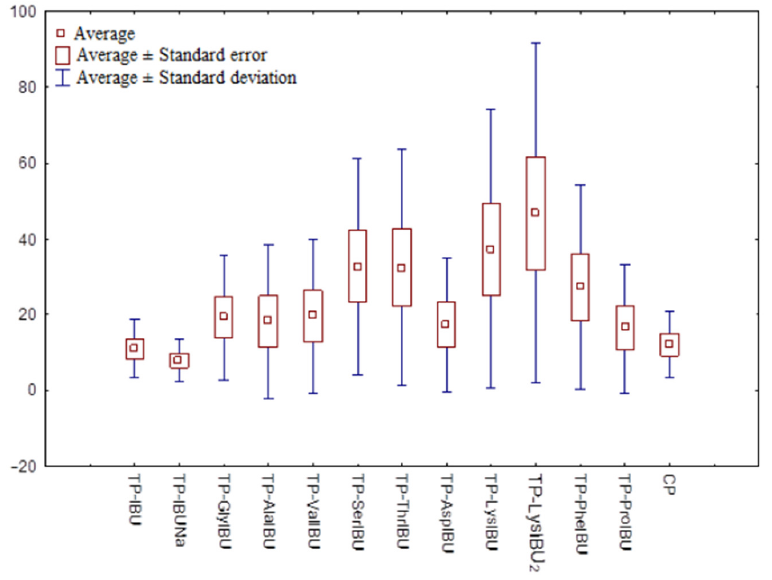
Figure 7. The box plot of cumulative mass for IBU and its derivatives after 24 h permeation. after 24 h of penetration. All the compounds used accumulated in the skin. The lowest accumulation for derivative IBU values was obtained for TP-AlaIBU (30.602 ± 2.847 µg IBU/g skin), while the greatest accumulation in the skin was observed for TP-GlyIBU (65.237 ± 0.781 µg IBU/g skin) (Figure 8).